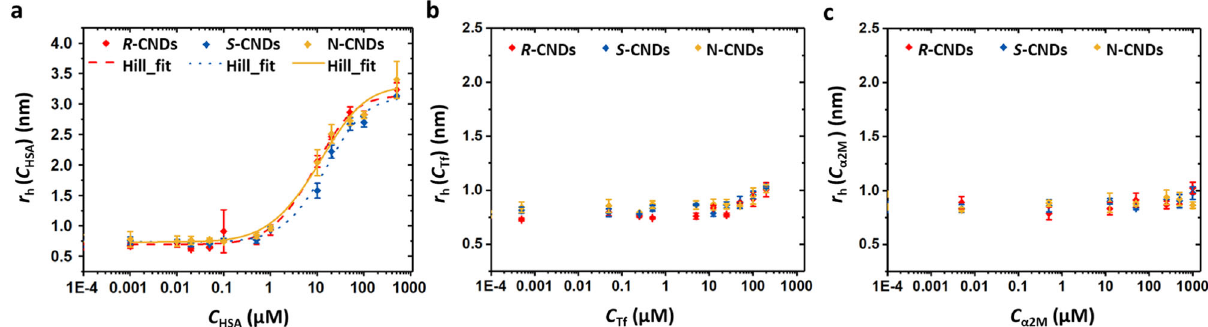
Fig. 2 Change of hydrodynamic radius r h of CNDs (batch #1) as recorded in phosphate-buffered saline (PBS) in dependence of the protein concentration. a HSA; b Tf; c α 2M. From the plots the fi t parameters K D , N max , n , r h,0 , and Δ r h,max were obtained, which are listed in Table 2. K d is the apparent dissociation constant of the CND-protein complex, N max is the maximum number of bound proteins per CND under saturation conditions, n is the Hill coef fi cient, r h,0 is the hydrodynamic radius of the CNDs without attached proteins, and Δ r h,max is the difference in effective hydrodynamic radius between CNDs saturated with proteins and CNDs without attached proteins. The shown data were obtained with batch #1. Results are shown as mean values with error bars (i.e. the corresponding standard deviations) from three independent samples ( n = 3) over three independent experiments. Table 2 Parameters describing the interaction of CNDs and